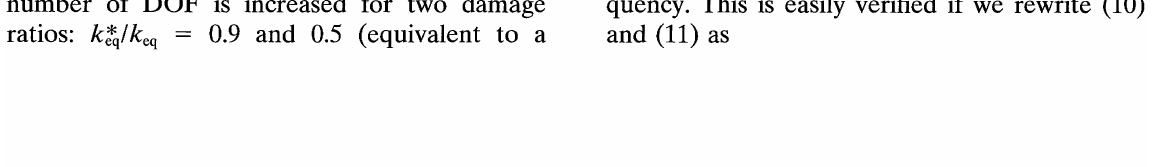
Table 2. Frequency and Deflection Sensitivities for Longitudinal Motion of Fixed-Free Beam for Two Values of Damage Ratio, kt/keq = 0.9 and 0.5; Spring kl Damaged k':qlkeq = 0.9 k~./ keq = (ct. 1.571)